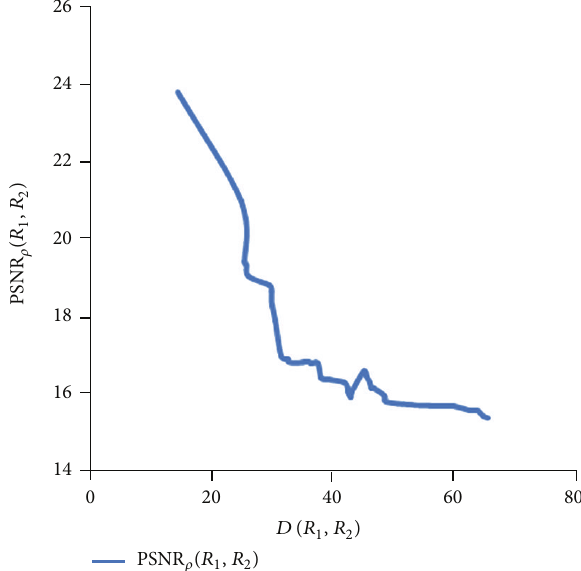
Figure 4: Trend of PSNR with respect to 𝐷 index for the eraser obtained from the comparison with the sample image at 𝜃 = 11 ∘ and 𝜙 = 36 ∘